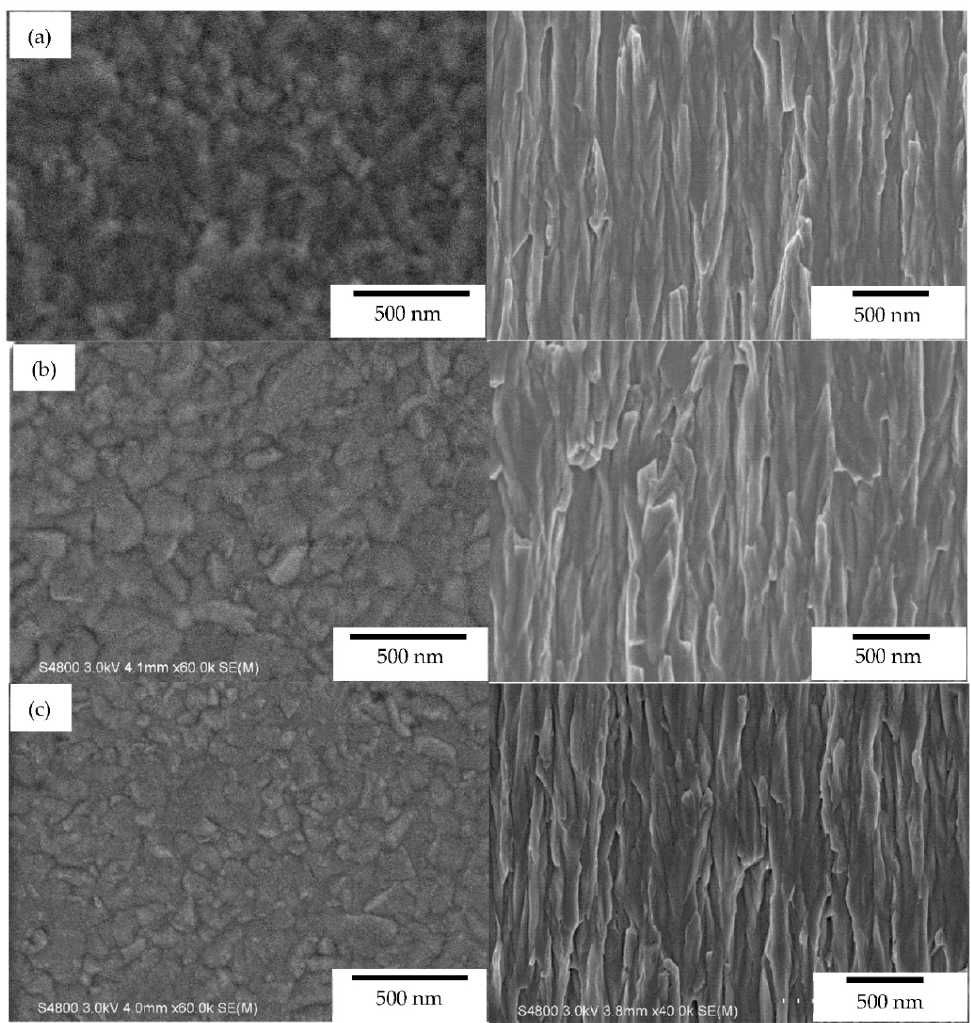
Figure 5. Top (left side) and cross-sectional (right side) SEM SE micrographs of Zr films deposited with the target pulse width of ( a ) 60 μ s, ( b ) 200 μ s, and ( c ) 400 μ s, at the argon pressure of 1.2 Pa on the silicon wafer chips with applying synchronized substrate pulse bias − 200 V.